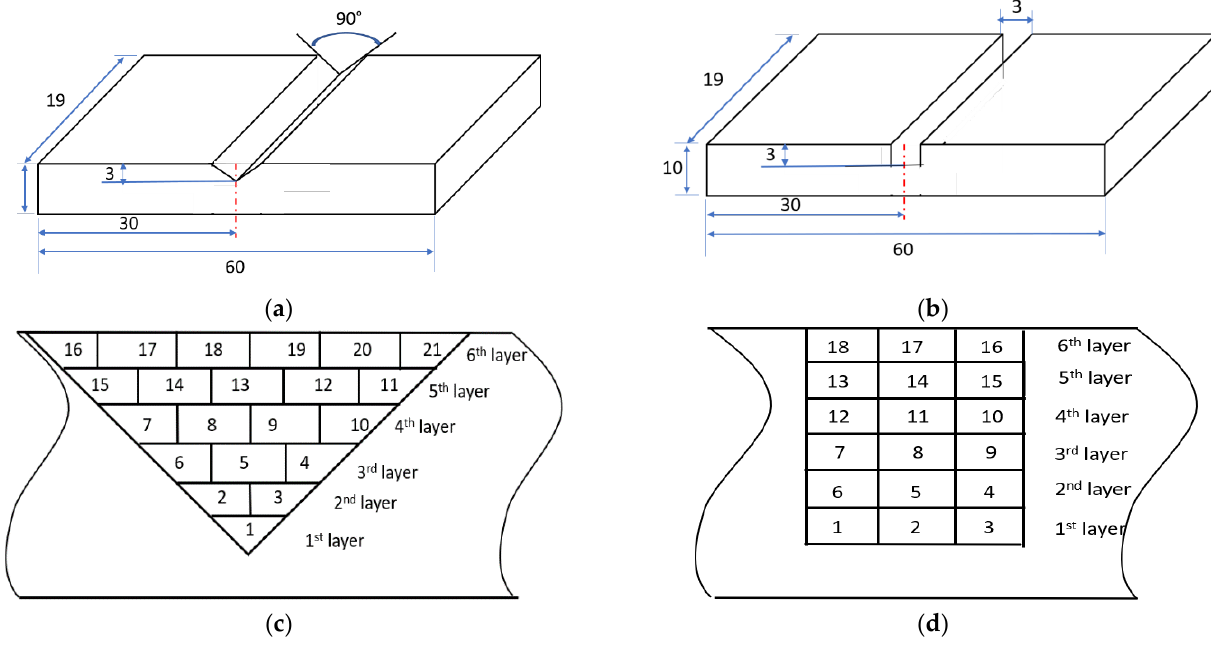
Table 1. Chemical composition of the target materials (wt.%).